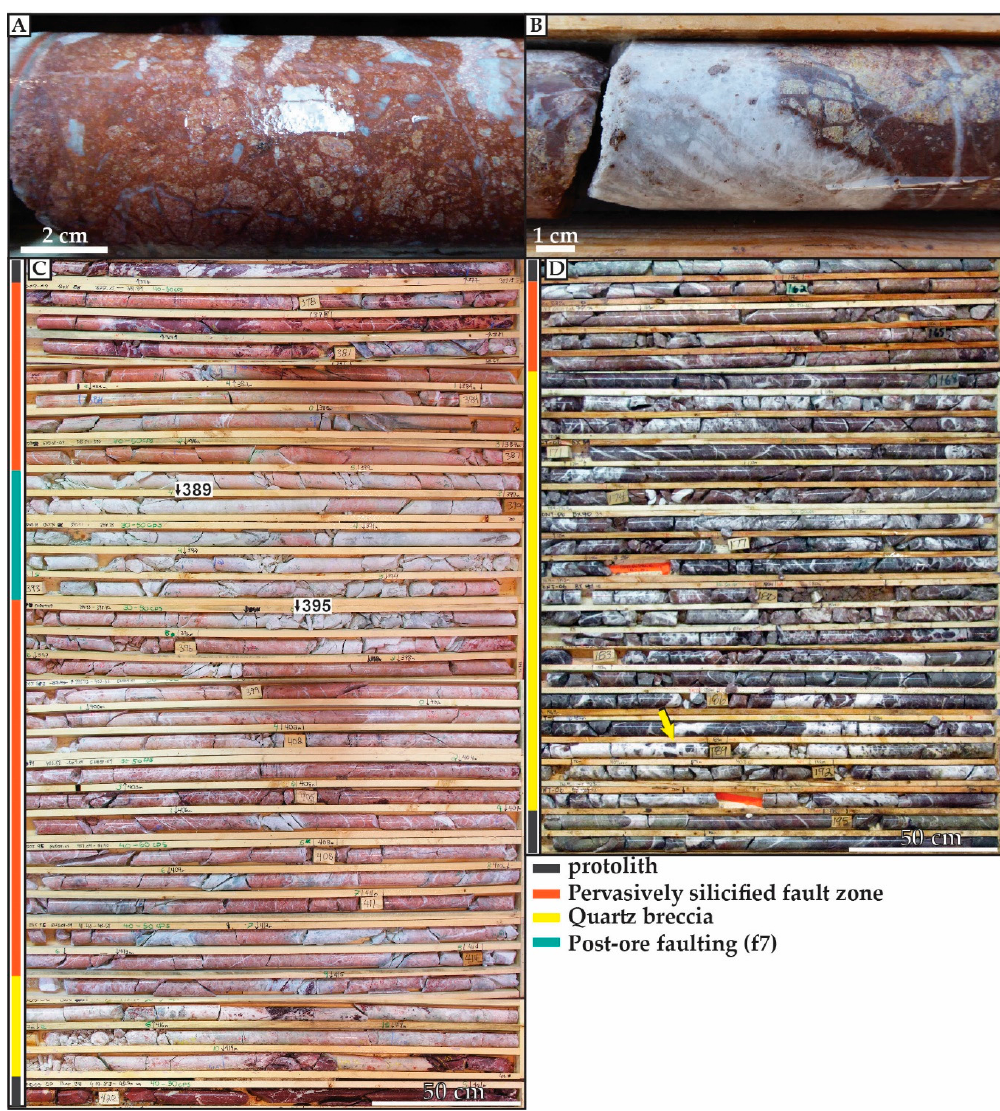
Figure 4. ( A ) Pervasively silicified cataclastic fault rock; ( B ) same as ( A ), crosscut by a white quartz vein of the QB; ( C ) pervasively silicified fault zone crosscut by late fracturing and clay alteration event (End deposit); and ( D ) typical intersection of the QB displaying deep purple hematized rock, massive and minor white quartz veins. Jigsaw textures are locally observable (e.g., at 189 m, yellow arrow; Contact prospect).